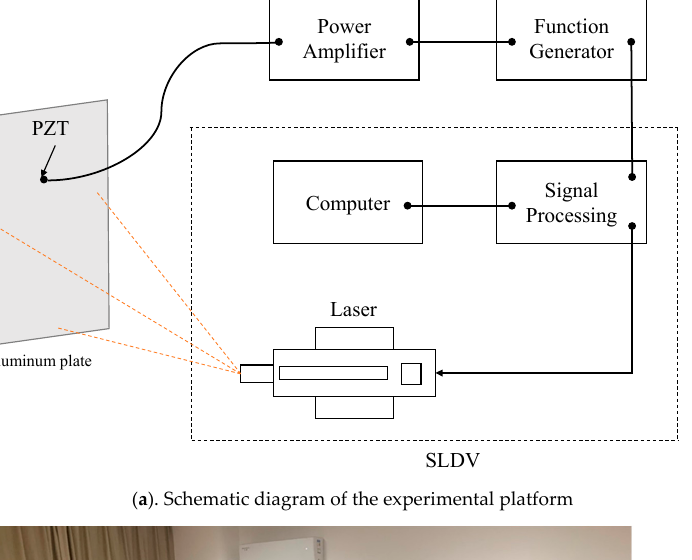
Figure 17. Experimental platform.